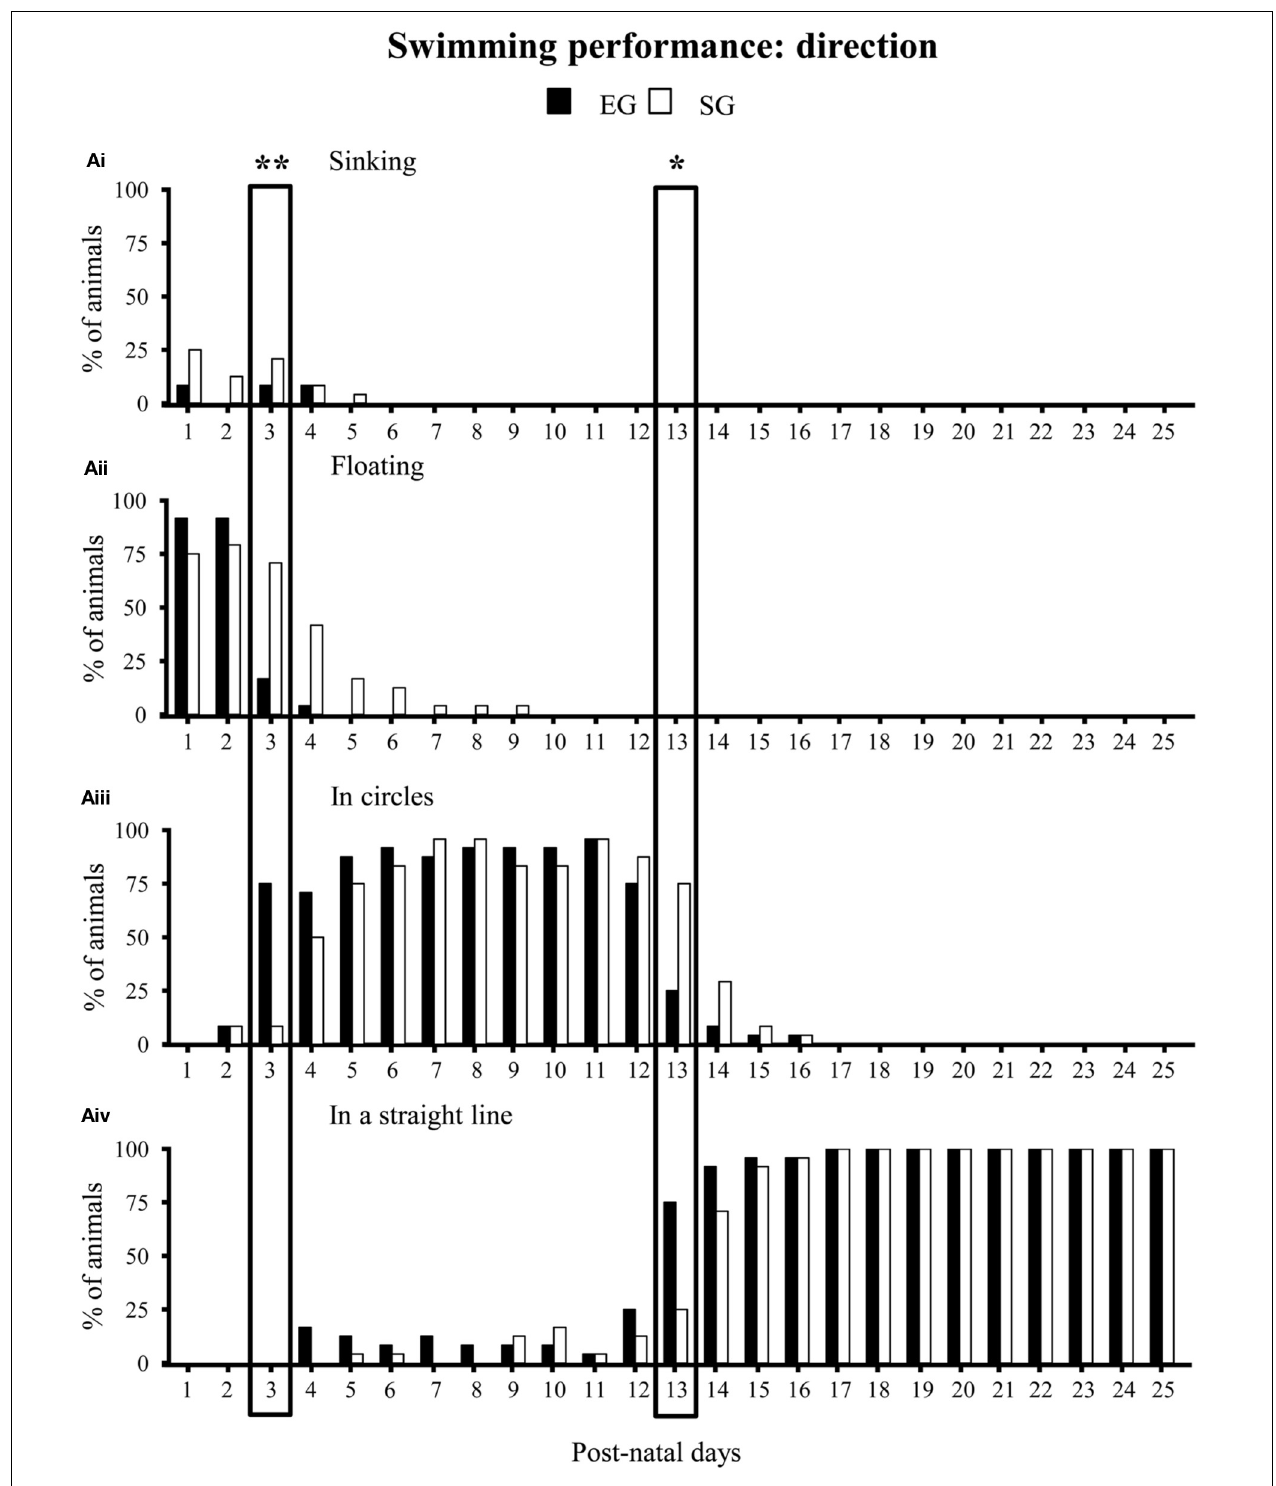
FIGURE 6 | Results of pre-reproductive maternal rearing condition on swimming direction. Histograms show percentages of EG ( N = 24) and SG ( N = 24) sinking (Ai) , floating (Aii) , swimming in circles (Aiii) or in a straight line (Aiv) from pnd 1 to pnd 25 ( ∗ p < 0 . 01; ∗∗ p < 0 . 001). The two boxes indicate that at pnd 3 and pnd 13 the score distribution